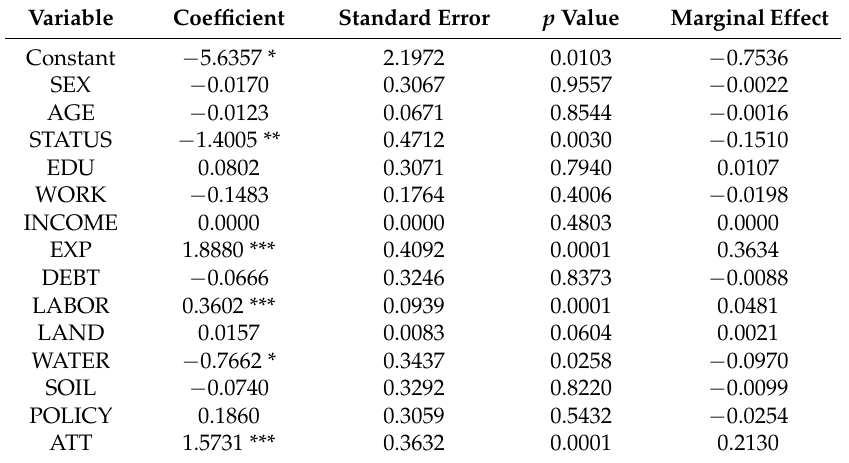
Table 4. Results of analysis of the factors affecting household succession in agricultural